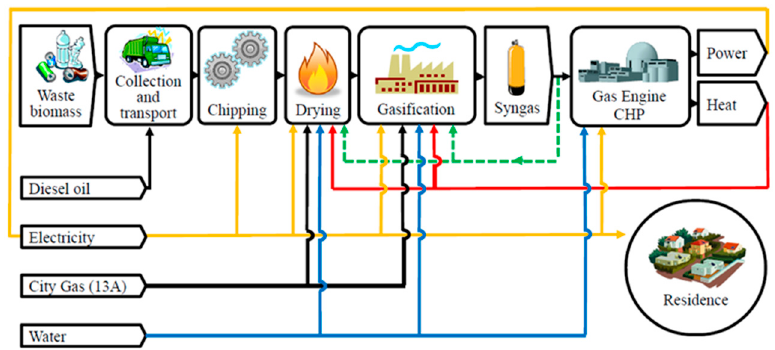
Figure 3. Schematic diagram of the overall energy generation process.